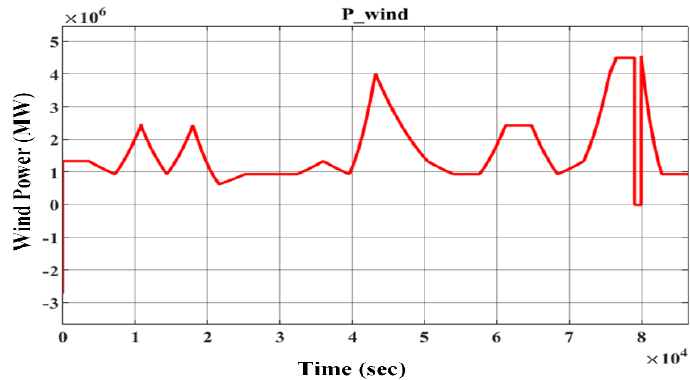
Figure 9. Total output power of wind.